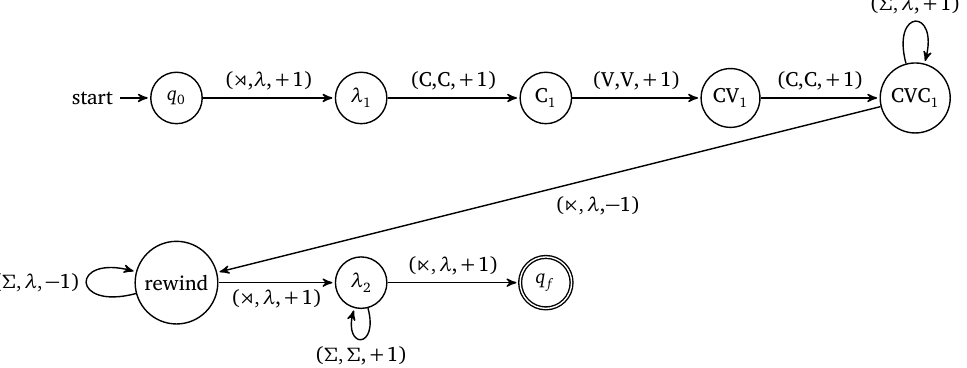
Figure 12: C-OSL 2-way D-FST for initial-CVC partial